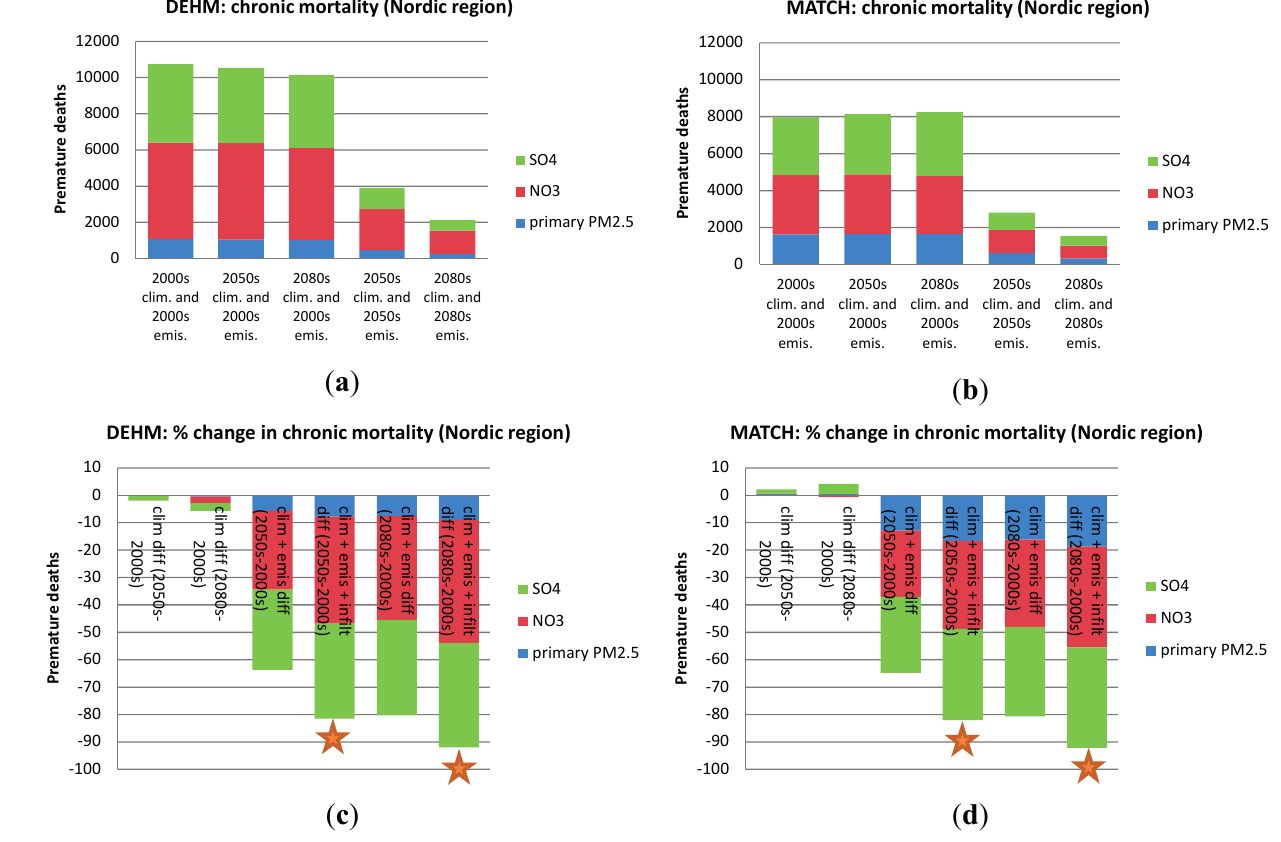
Figure 7. As in Figure 5, but for the Nordic region only (Sweden, Finland, Norway and Denmark). Here an estimate of the change in infiltration rate has also been included in the simulations where both climate and emissions are changed (see Section 3.5). These simulations are marked by a